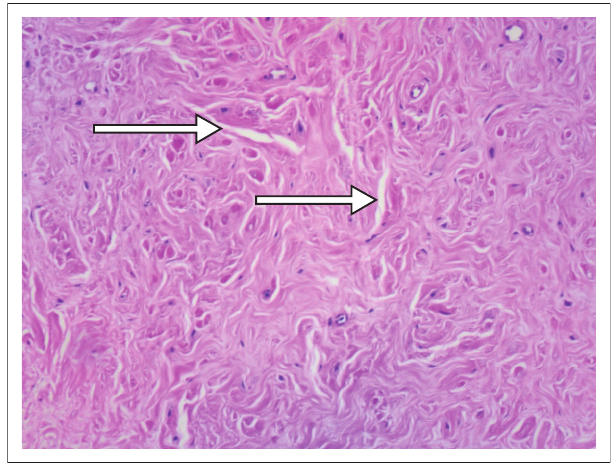
FIGURE 7: Arrows indicate the pseudovascular